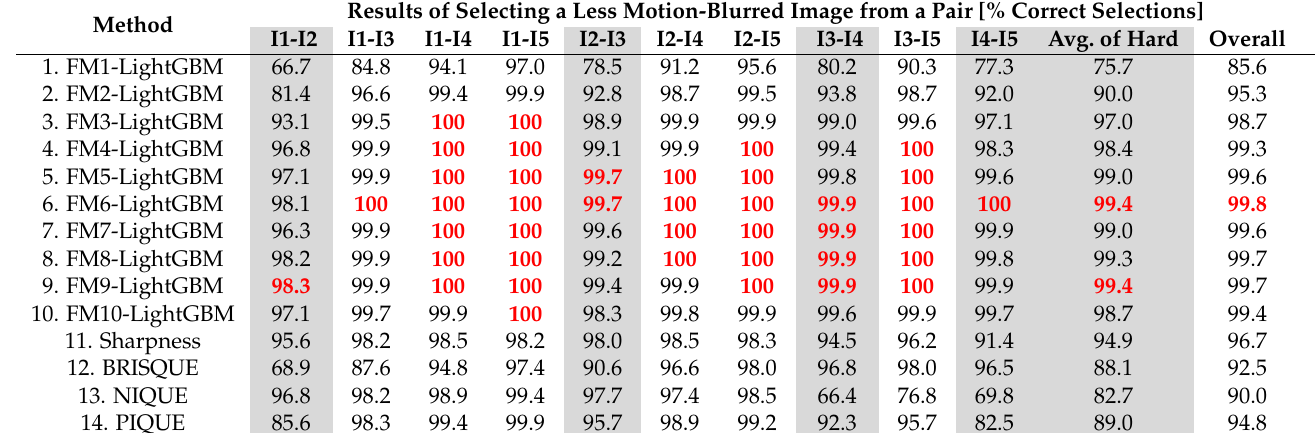
Table 2. Method comparison results of selecting a less motion-blurred image from a pair of images. Images are of the mannequin head. Values in the table are the percentages of selections that were correct. Images in the pairs are the following: I1—original image; I2—AT+MB1 (original image altered by affine transformation + motion blur #1); I3—AT × 2+MB2 (original image altered by the previous affine transformation twice + motion blur #2); I4—AT × 3+MB3; I5—AT × 4+MB4. The best performance in each comparison group (column) is highlighted in red. The dark background of the cells highlights comparison results of harder image pairs, i.e., image pairs that are the most similar according to the motion blur